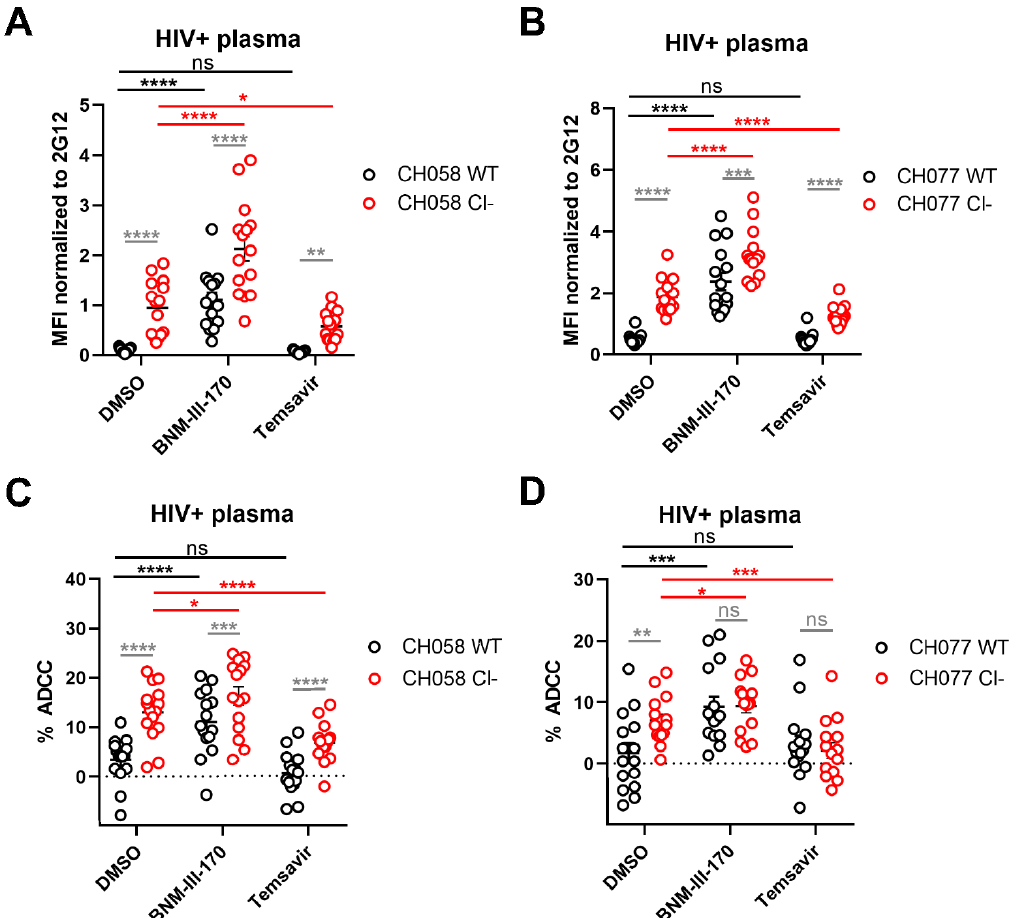
Figure 3. Env cleavage protects HIV-1-infected cells from ADCC mediated by HIV+ plasma. ( A , B ) Cell surface staining of primary CD4+T cells infected with primary HIV-1 viruses ( A ) CH058 and ( B ) CH077 WT or their cleavage-deficient (Cl-) variants using plasma from 15 different HIV-1-infected individuals in the presence of 50 µM of CD4mc BNM-III-170, conformational blocker Temsavir or an equivalent volume of the vehicle (DMSO). The graphs show the MFI obtained on the infected (p24+) cell population. ( C , D ) Primary CD4+ T cells infected with ( C ) CH058 and ( D ) CH077 viruses were also used as target cells, and autologous PBMCs were used as effector cells in a FACS-based ADCC assay. The graphs shown represent the percentages of ADCC mediated by 15 different HIV+ plasma in the presence of 50 µM of CD4mc BNM-III-170, attachment inhibitor Temsavir or an equivalent volume of the vehicle (DMSO). All results were obtained using cells from at least three different donors. Error bars indicate the means ± SEM. Statistical significance was tested using a repeated measures one-way ANOVA with a Holm–Sidak post-test (* p < 0.05; ** p < 0.01; *** p < 0.001; **** p < 0.0001; ns,